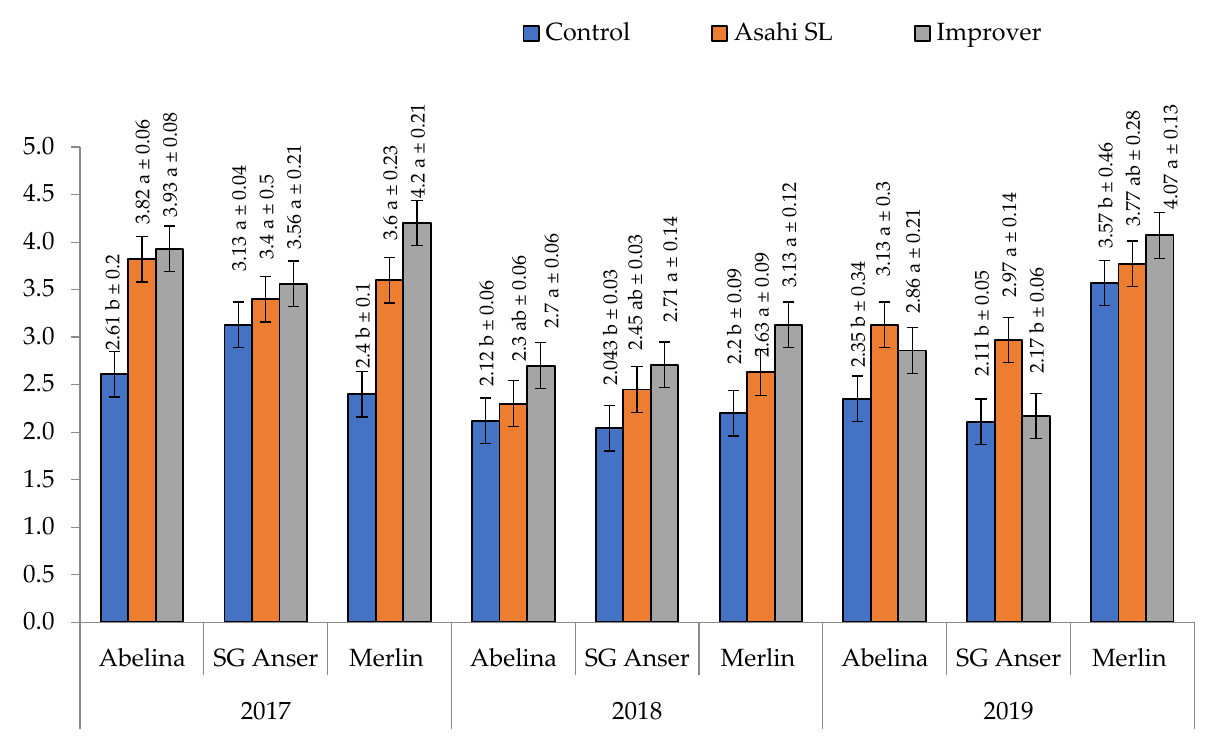
Figure 1. Soybean yield performance according to cultivars and biostimulants in 2017 – 2019. Means followed by different letters in lowercase: a and b differ significantly at the p ≤ 0.05; ±Se (standard error) value.